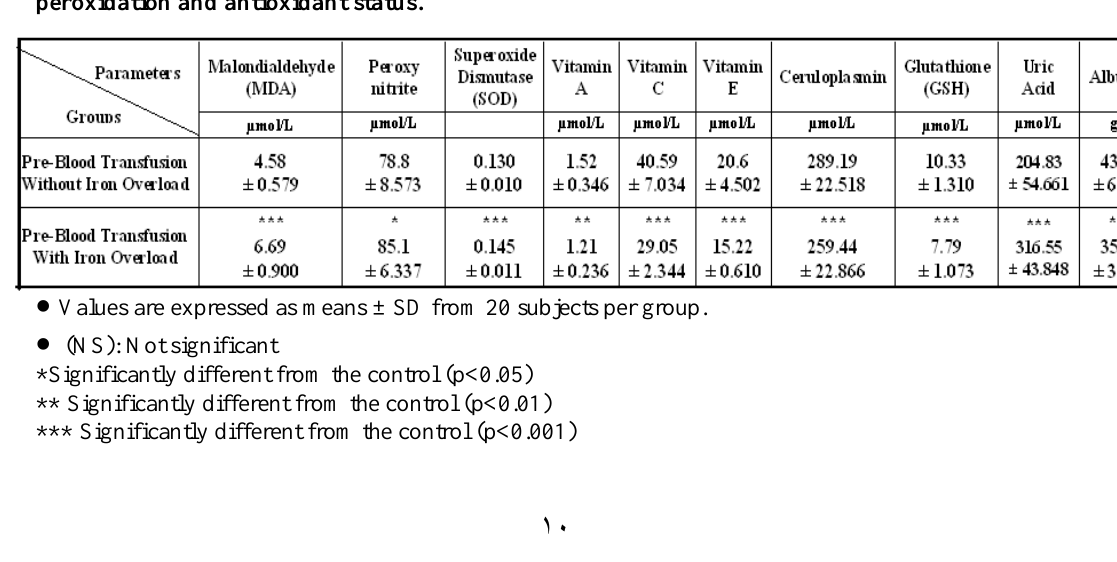
Table 3: Effects of iron overload in thalassemic patients, before blood transfusion, on lipid peroxidation and antioxidant